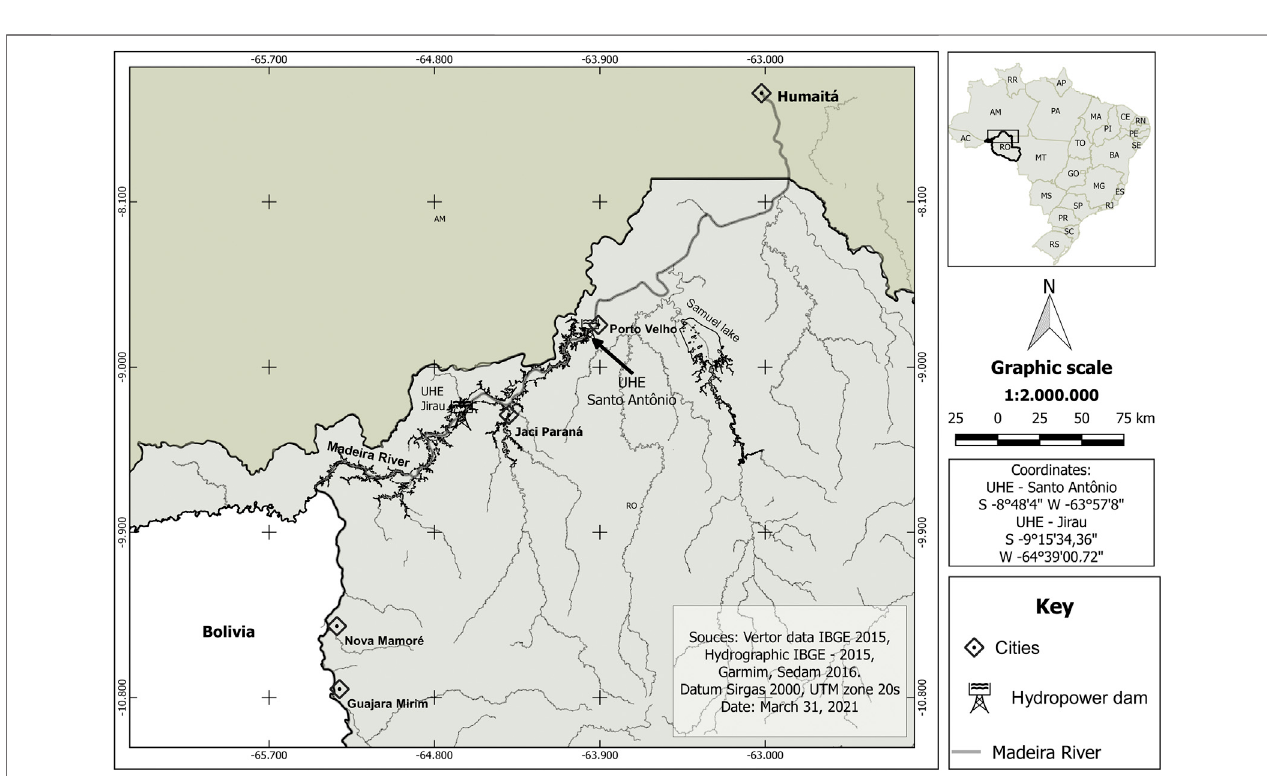
FIGURE 1 | Geographic location of the study area, showing the Madeira River crossing Rond ˆ onia State (Brazil), and the Jirau and Santo Ant ˆ onio dams.